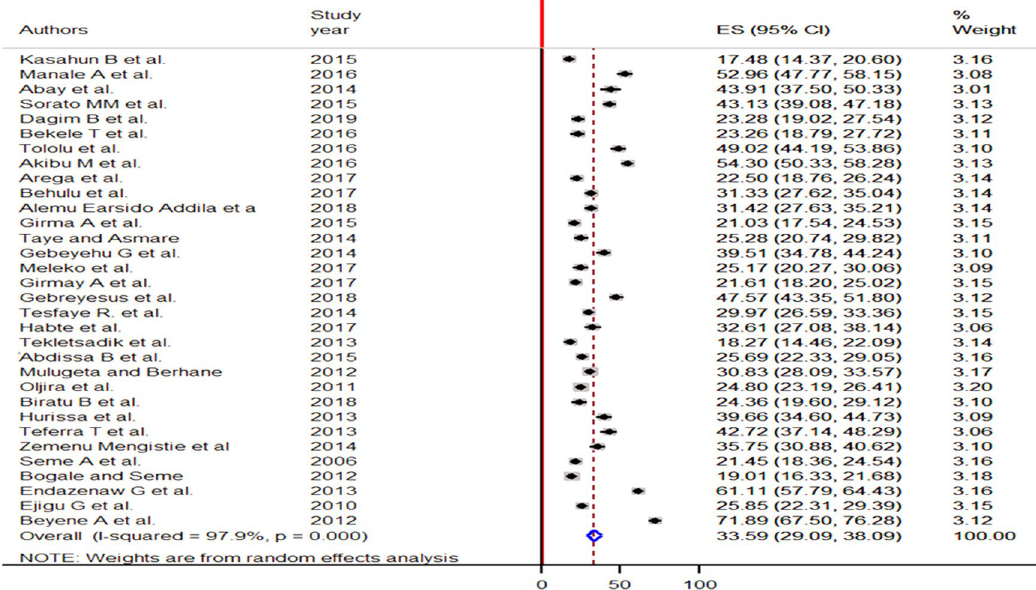
Figure 2. Forest plot of the pooled prevalence of pre-marital sex among young individuals in Ethiopia, 2021.